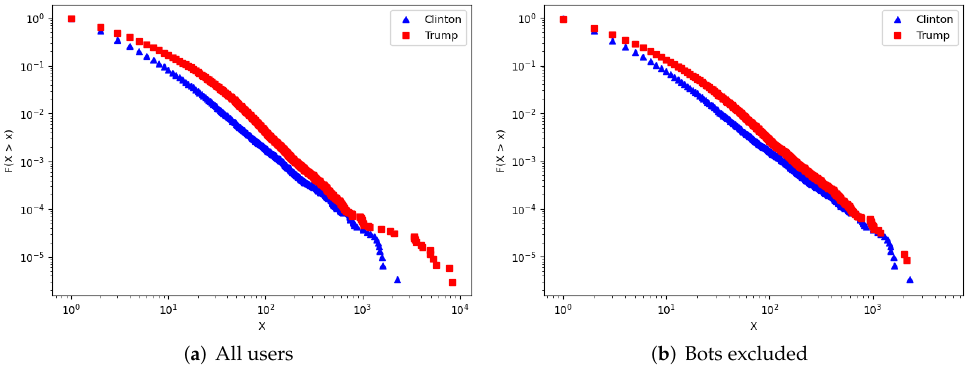
Figure 2. CCDF of published posts for real and bot users classified by supported faction.